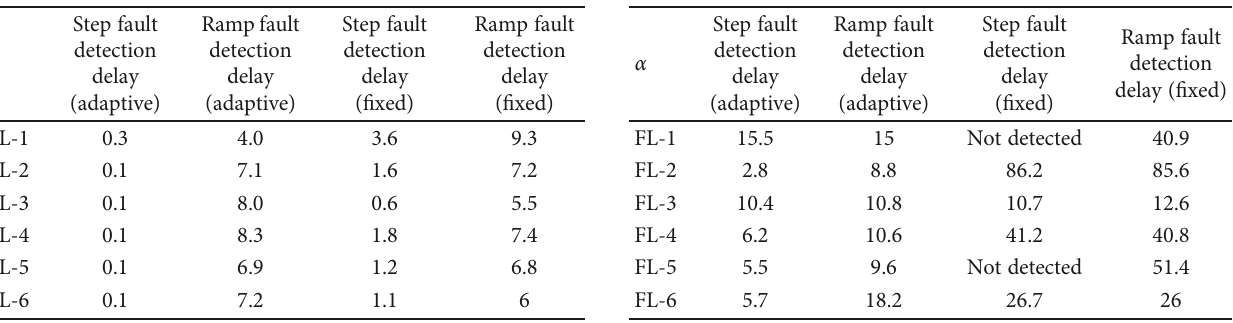
(b) Comparison between fi xed-threshold and adaptive-threshold detection delay for α : soft failures